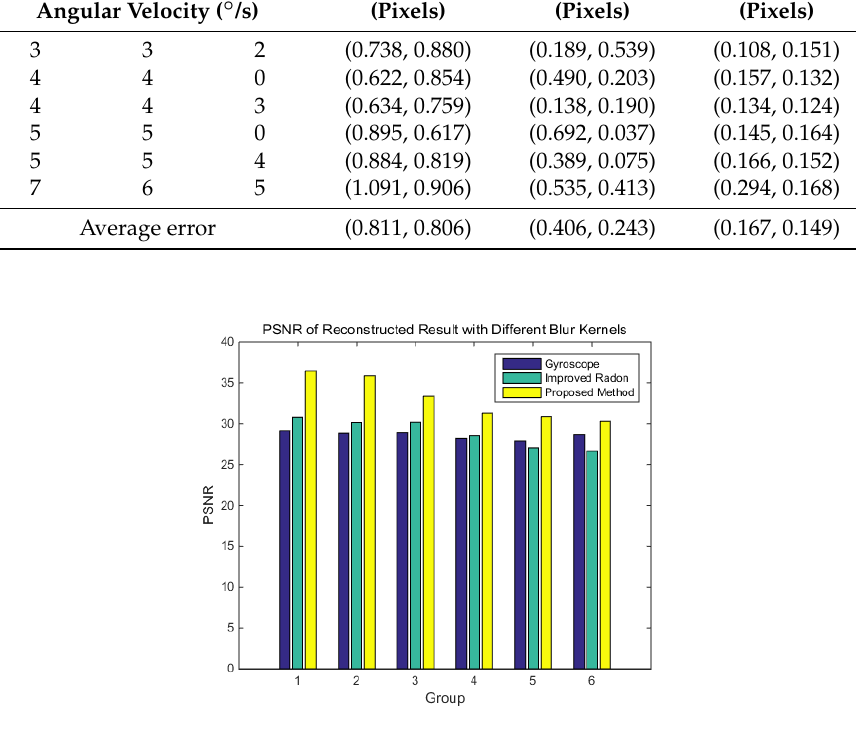
( d ) Figure 16. Reconstruction results of different methods. ( a ) Reconstruction result of the Wiener filter. ( b ) Reconstruction result of the accelerated Richardson – Lucy (RL) method. ( c ) Reconstruction result of p -regularization. ( d ) Reconstruction result of the proposed method. To verify the performance of the reconstruction methods for the different blurred star images, the comparison experiment is carried out at different angular velocities. The results are evaluated